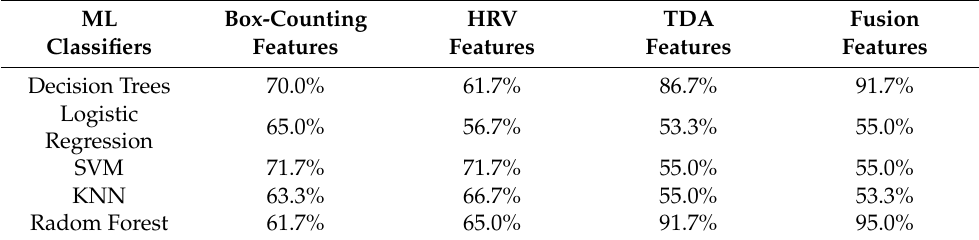
Table 5. Combination of different types of features and